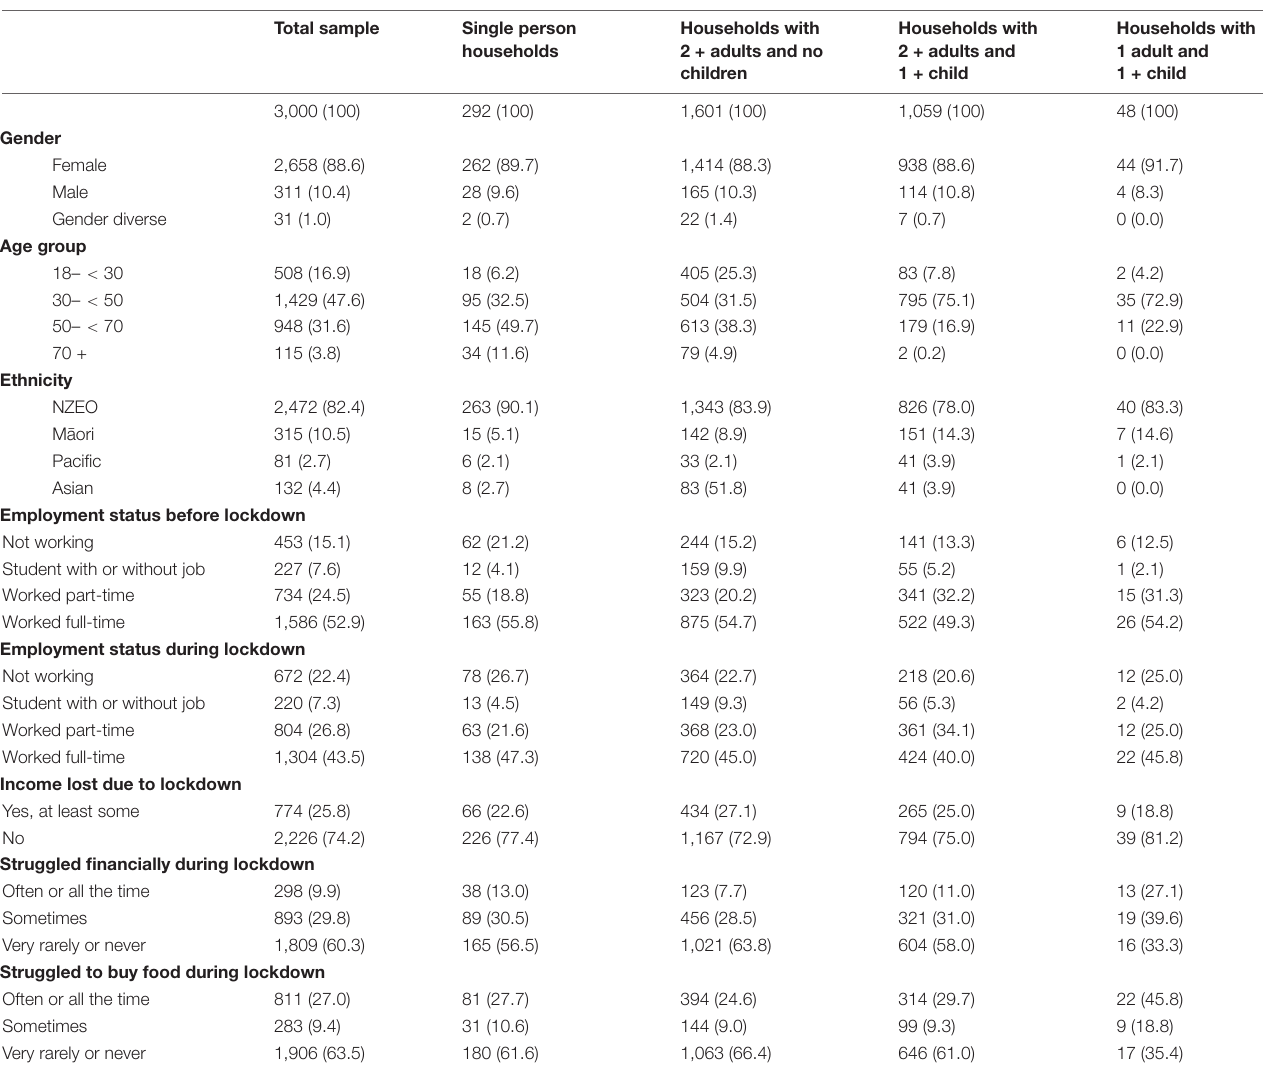
TABLE 1 | Sociodemographic